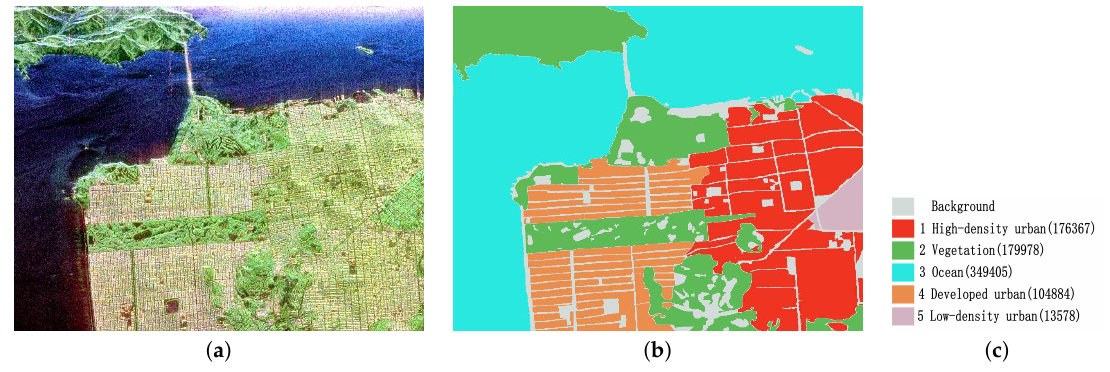
Figure 8. San Francisco dataset. ( a ) Pauli RGB. ( b ) Ground Truth. ( c )